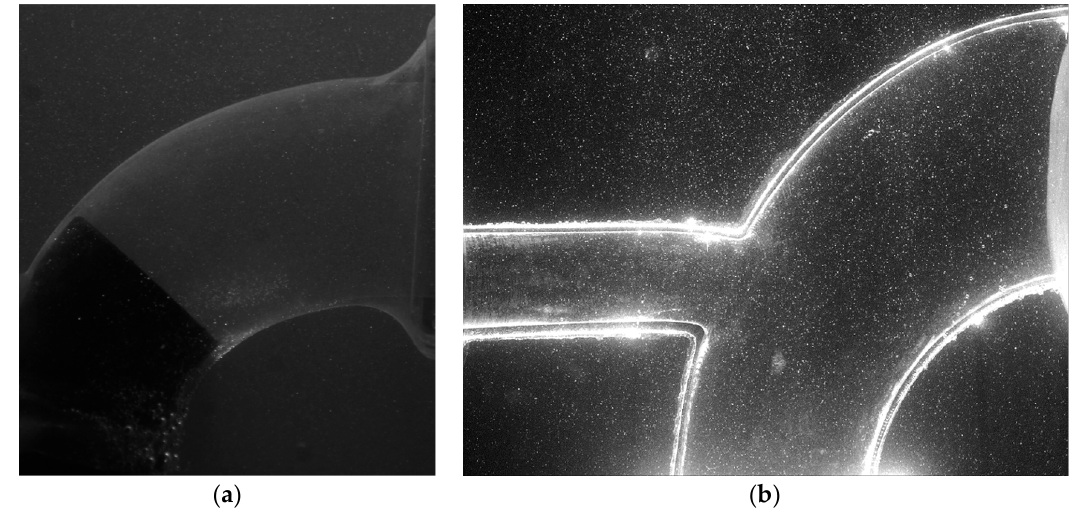
Figure 6. Raw PIV images; ( a ) initial model, ( b ) second model.